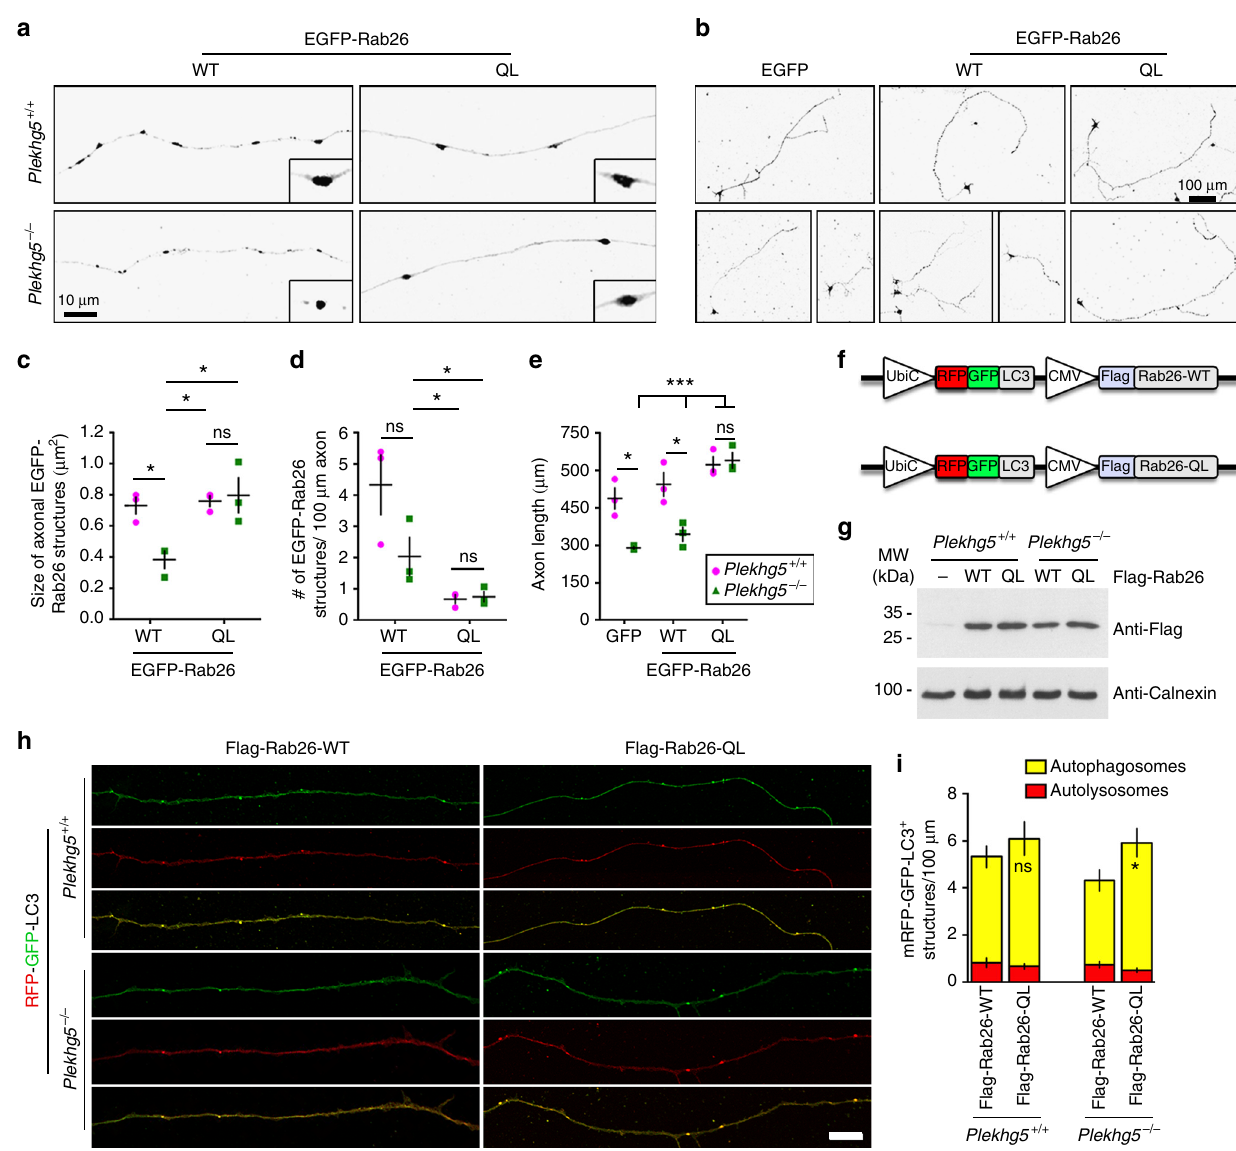
Fig. 8 Expression of constitutively active Rab26 rescues axonal growth and autophagy defects in Plekhg5-de fi cient cells. a Representative images of GFP-Rab26-WT or GFP-Rab26-QL positive structures in axons of control cells and Plekhg5-de fi cient cells. Scale bar : 10 µ m. b Morphology of GFP, GFP-Rab26-WT or GFP-Rab26-QL expressing motoneurons cultured for 7 days. Scale bar : 100 µ m. c , d Size and number of axonal EGFP-Rab26 structures. e Axon length of GFP, GFP-Rab26-WT, or GFP-Rab26-QL expressing motoneurons isolated from Plekhg5 +/+ and Plekhg5 − / − mice (each data point represents one individual experiment with 15 cells analyzed in each experiment; mean ± SEM; two-way ANOVA). f Scheme of lentiviral vectors for simultaneous expression of RFP-GFP-LC3 and Flag-Rab26-WT or Flag-Rab26-QL, respectively. g Western blot analysis of Flag-Rab26-WT and Flag-Rab26- QL expression. Images have been cropped for presentation. Full size images are presented in Supplementary Fig. 7. h Motoneurons of Plekhg5 + / + and Plekhg5 − / − mice expressing mRFP-GFP-LC3 and Flag-Rab26-WT or Flag-Rab26-QL were cultured for 7 days and the number of mRFP-GFP-LC3 positive structures was analyzed. Scale bar : 10 µ m. i Number of autophagosomes and autolysosomes upon expression of Flag-Rab26-WT and Flag-Rab26-QL (three independent experiments with 10 cells analyzed in each experiment; mean ± SEM; two-way ANOVA; Bonferroni